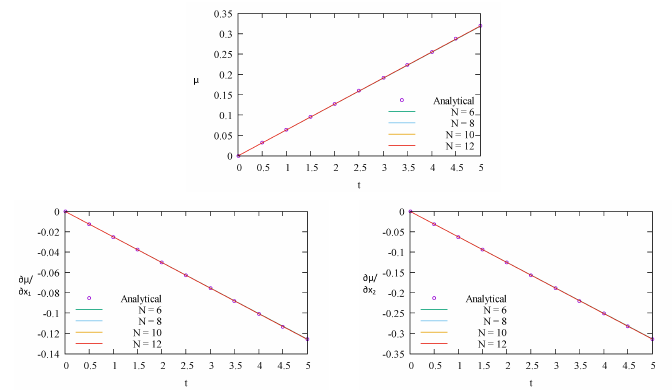
Figure 5. The solutions µ , ∂µ/∂x 1 and ∂µ/∂x 2 at ( x 1 ,x 2 ) = (0 . 5 , 0 . 5) for Case